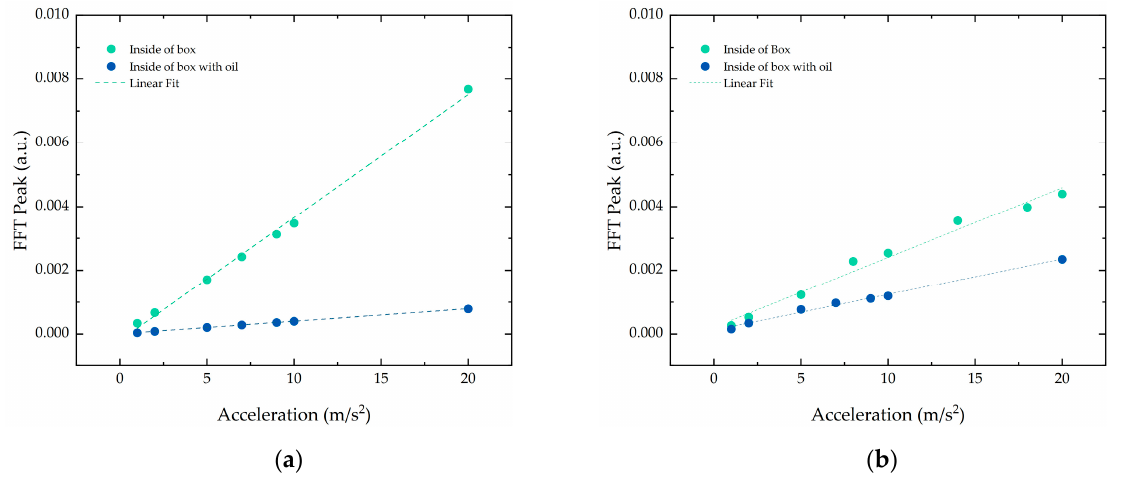
Figure 7. Signal peak value at 100 Hz for accelerations applied to the structure inside the simulation environment before and after adding the oil in the ( a ) vertical and ( b ) horizontal direction.